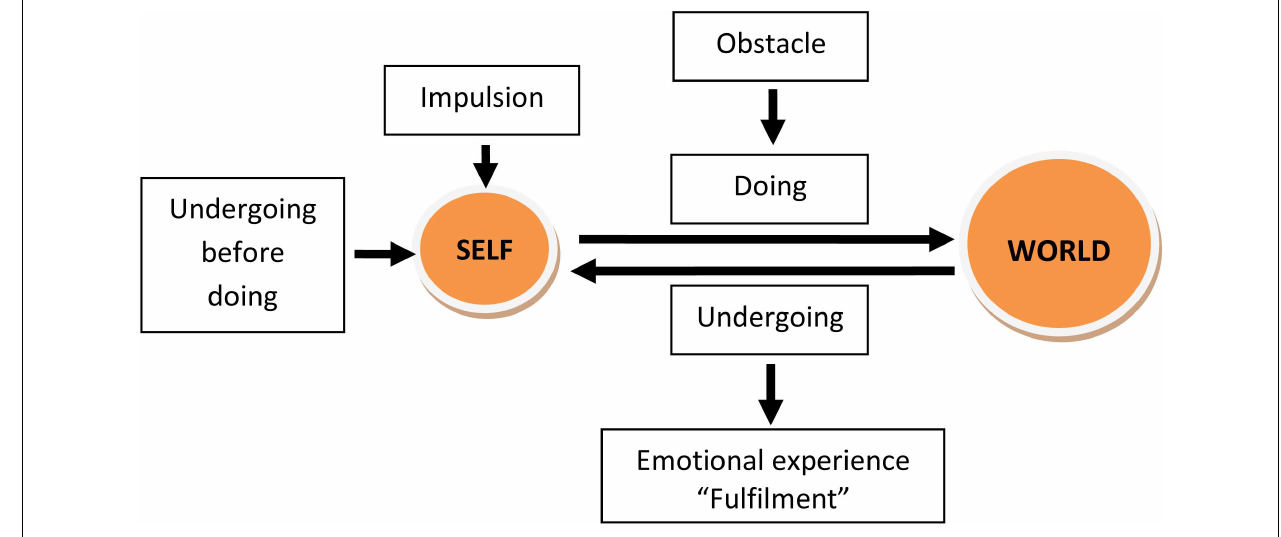
FIGURE 1 |A model of human experience (after Dewey,